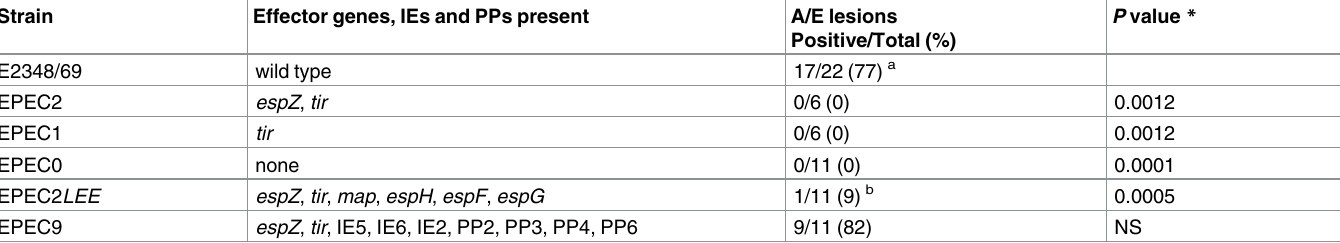
Table 2. A/E lesions in human intestinal biopsies infected with EPEC effector mutants.